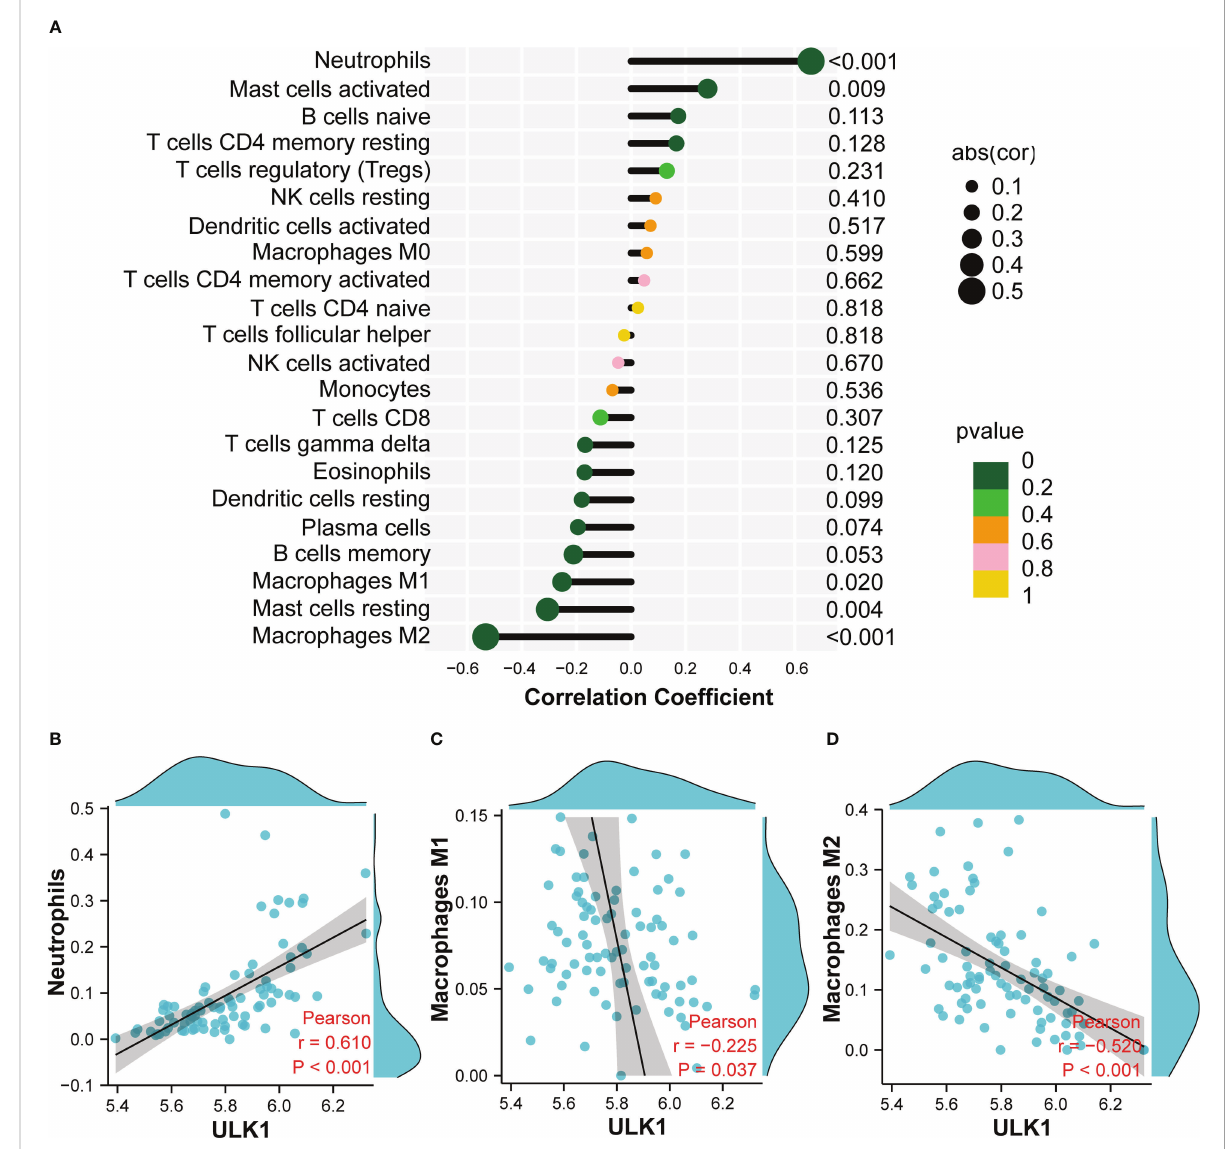
FIGURE 9 Correlation analysis between ULK1 and in fi ltrating immune cells. (A) Correlation Analysis diagram showing the correlation between ULK1 and In fi ltrating Immune Cells. (B) Scatter diagram indicating the correlation between ULK1 expression and Neutrophils. (C) Scatter diagram indicating the correlation between ULK1 expression and Macrophages M1. (D) Scatter diagram indicating the correlation between ULK1 expression and Macrophages M2. Correlation analysis was assessed using Pearson